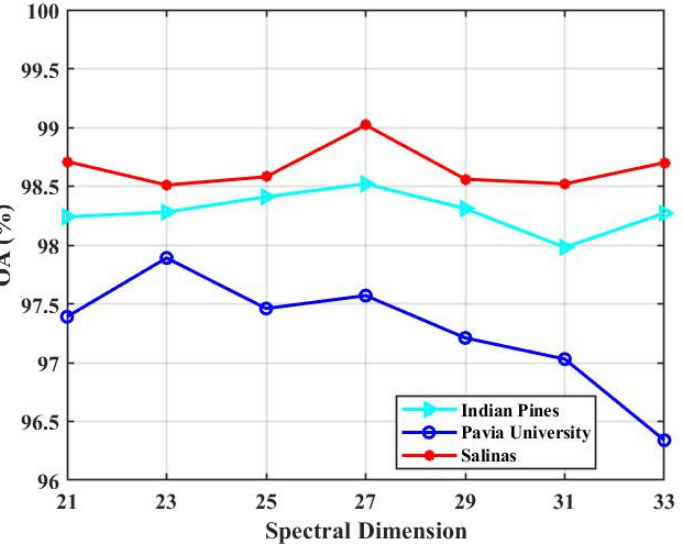
Figure 18. The classification result (OA) of our presented TSSFAN with different quantities of spectral dimensions in Input- 1 for all three HSI datasets.